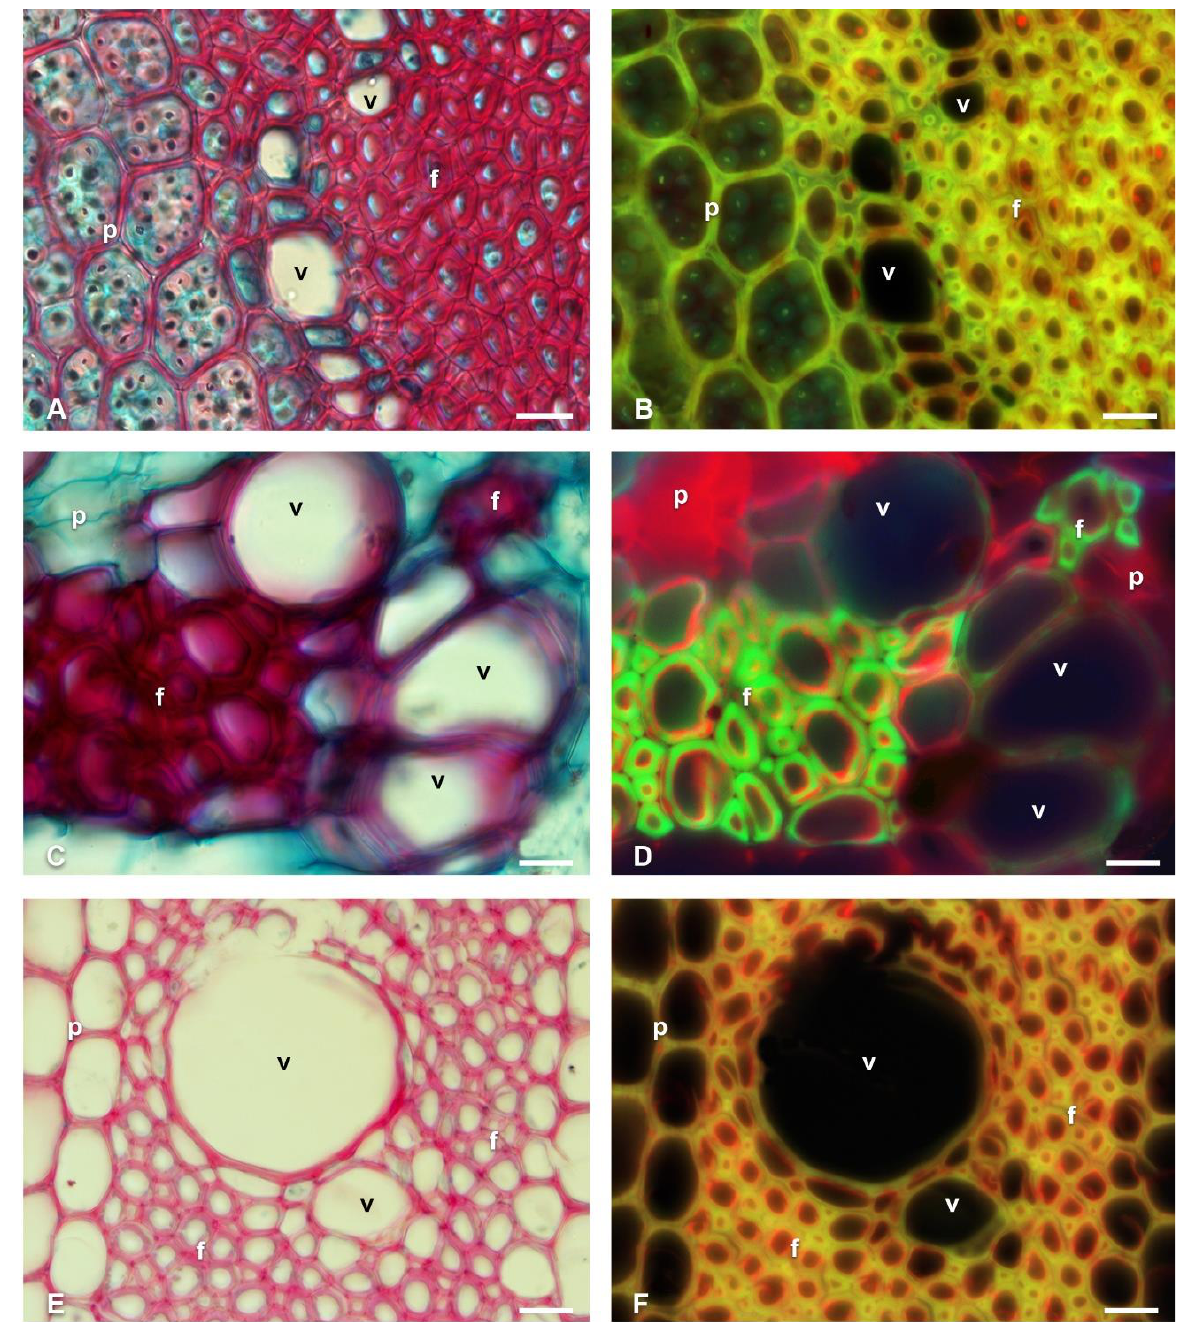
Figure 3. Fluorescence emission of transverse sections of fibrous wood species of Cactaceae. ( A , B ) Cylindropuntia leptocaulis . ( C , D ) Opuntia stenopetala . ( E , F ) Leuenbergeria lychnidiflora . f = fibers, p = parenchyma, v = vessel. Scale: 20 µm.